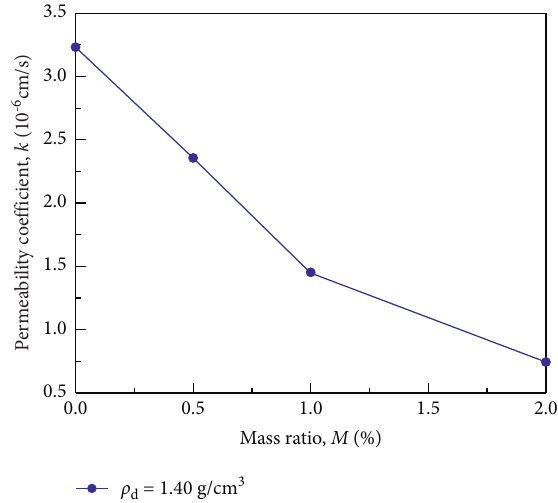
Figure 16: Effect of mass ratio on permeability